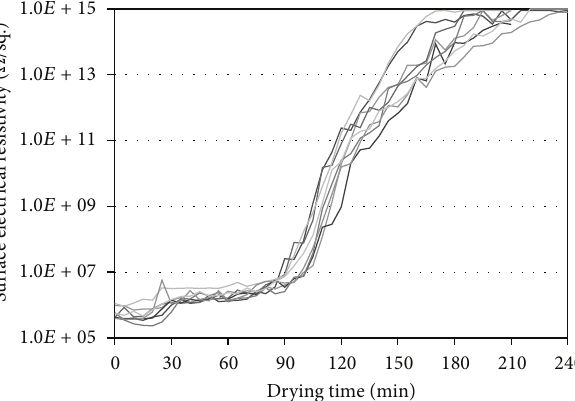
Figure 3: Transition of surface electrical resistivity measured on transverse surfaces of eight drying